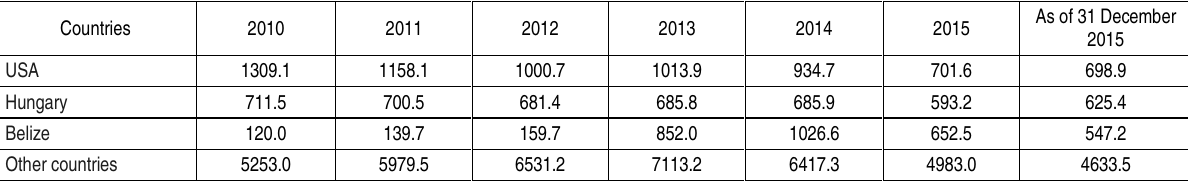
Table 2 (cont.). Foreign direct investments (joint-stock capital) of the world’s countries into the Ukrainian economy (volumes of direct investments as of January 1), million US dollars